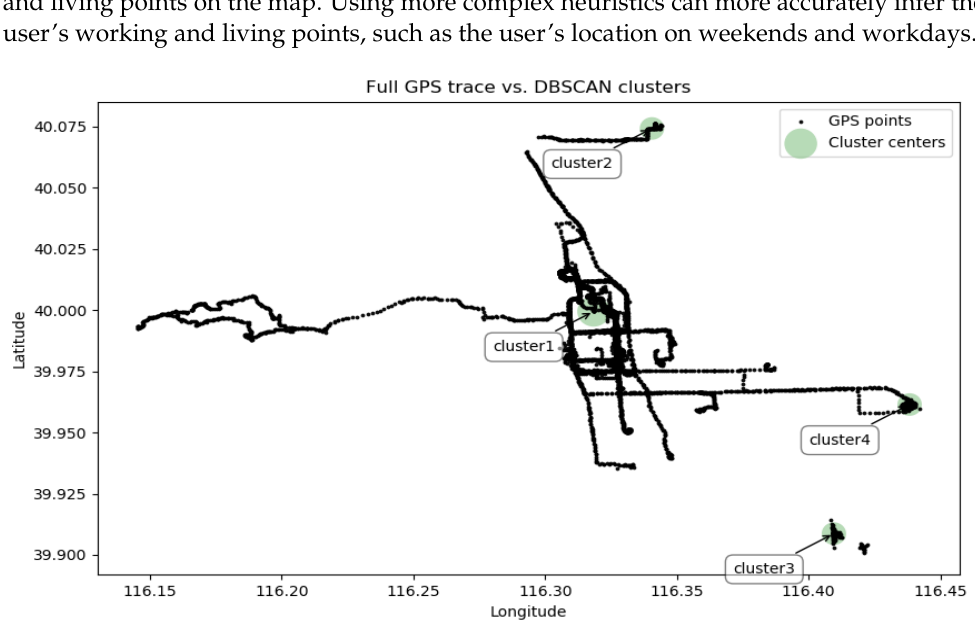
Figure 2. The illustration of user trajectory clustering. From the above example, we can know that, by observing the clusters of time, the attacker can infer individual’s habits, e.g., the working place and hours. Current methods attempt to add noise into the location to protect individual’s privacy, but they ignore the disclosure of time pattern. The motive of the attack model is to obtain important infor- mation about users, provide favorable research data for attackers, and achieve a better attack effect. 4. Methodology 4.1. Problem Definition